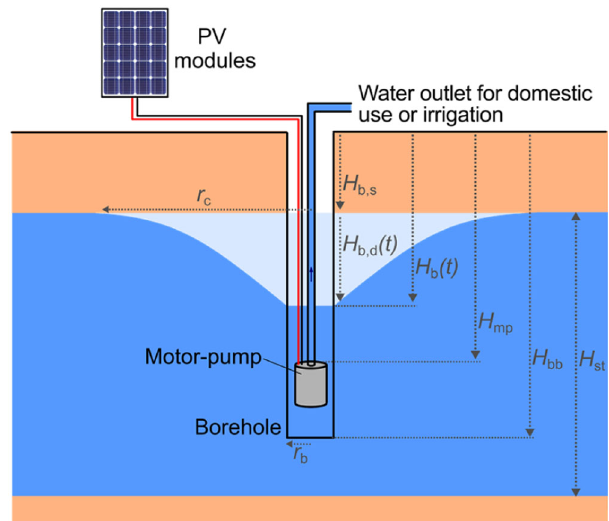
Fig. 1 Considered PVWPS architecture. All the lengths are de fi ned as positive. r b : borehole radius, H bb : borehole depth, H mp : motor-pump depth, H H st : aquifer saturated thickness, b,s : static water depth (depth when there is no pumping), H b,d : drawdown, H b : water depth in the borehole, r c : radius of the cone of